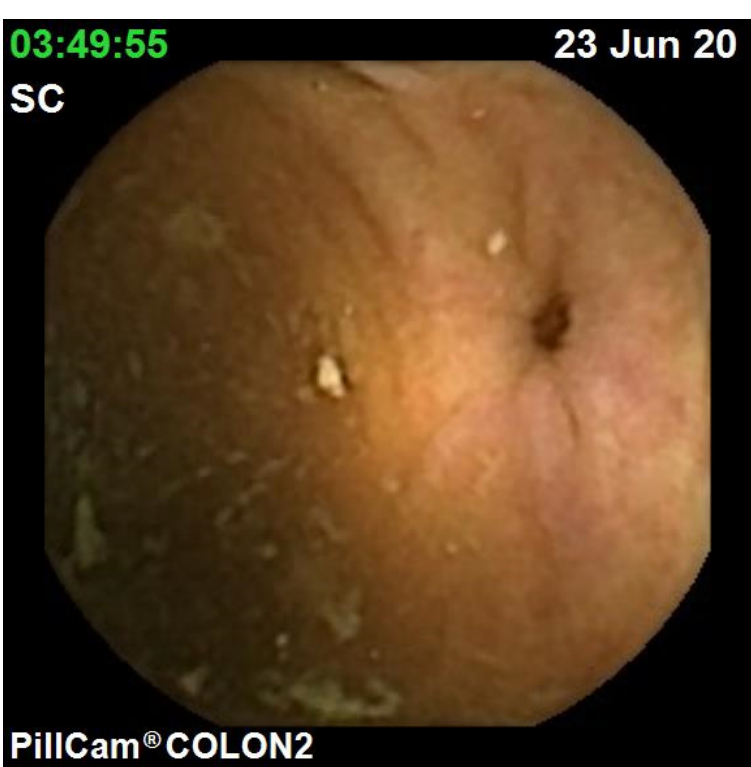
Figure 3. Haemorrhoid.